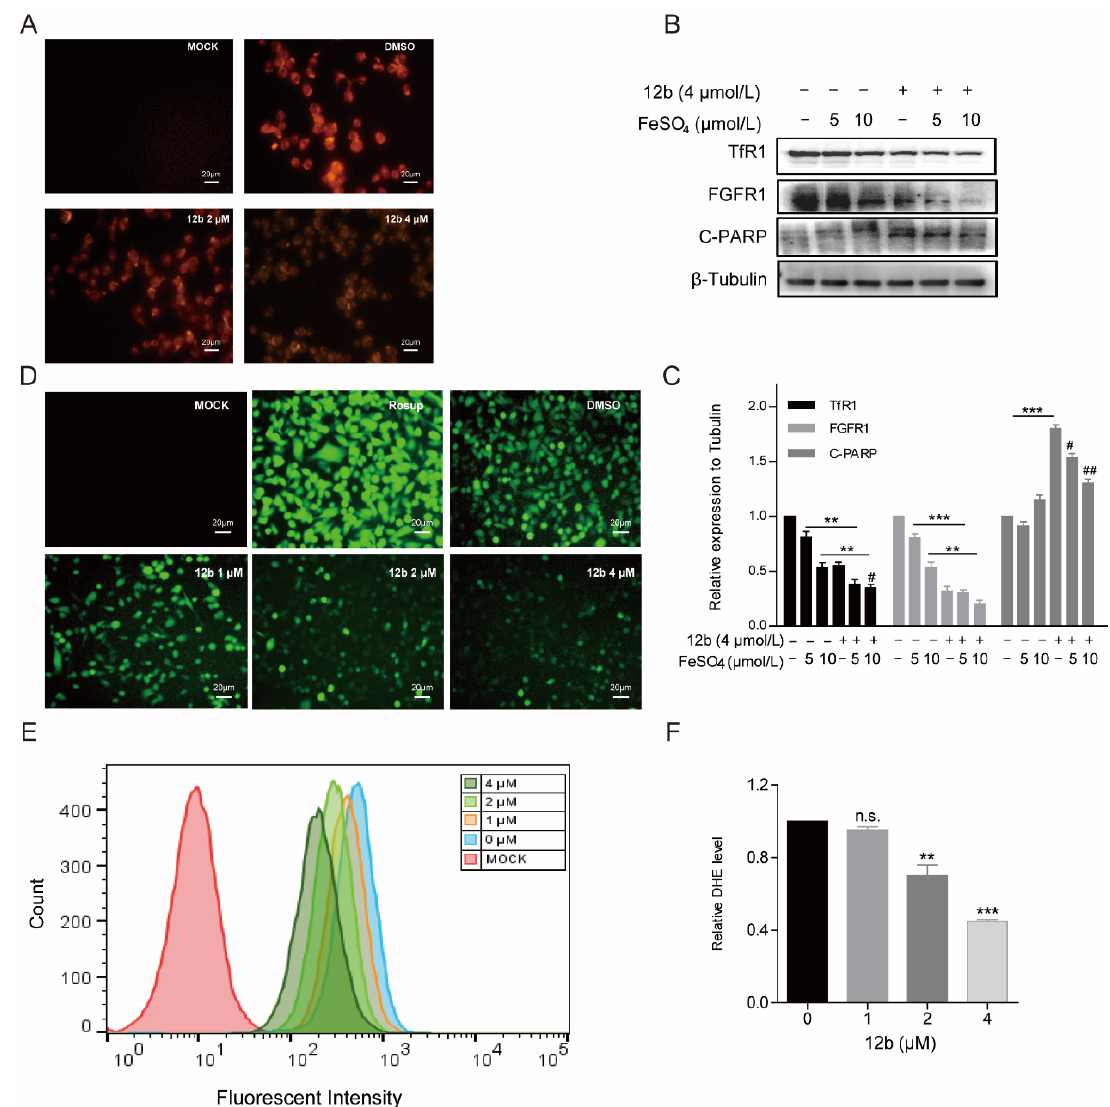
* Score: A description of the correlation of this candidate protein. † Matches: Number of high confi- dence images of mass spectrometry (confidence interval > 95%). ‡ Sequences: Number of highly reliable peptides matched to the compound. § emPAI: Protein content. Bold values are parameters of TfR1 in mass spectrometry analysis.